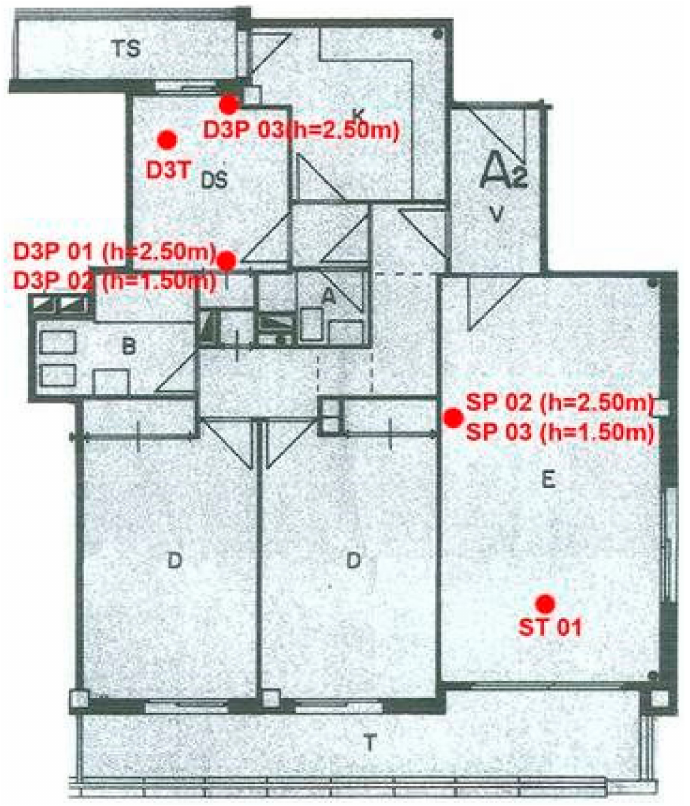
Figure 3. The positions of the core sampling